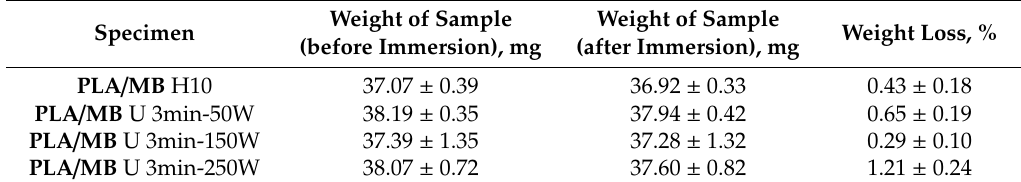
Table 3. Weight loss of the PLA / MB tablets after 120 days immersion in PBS.